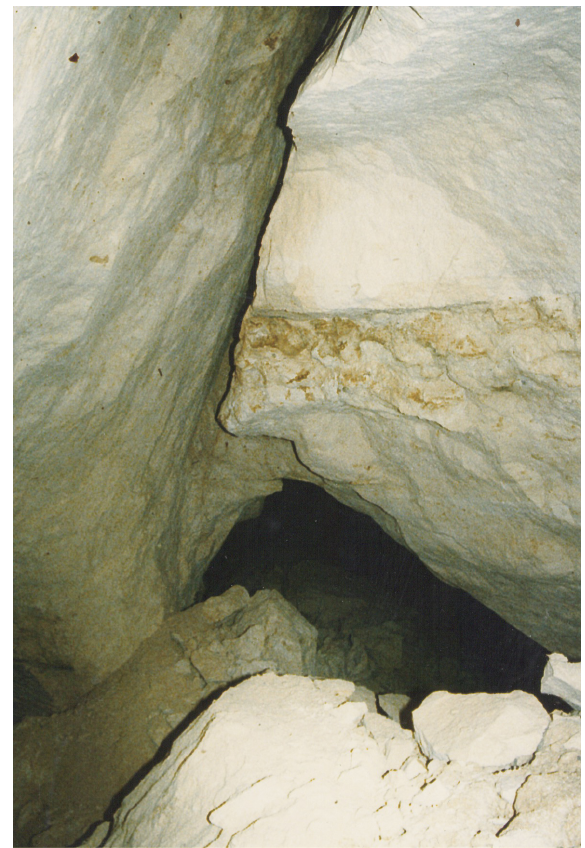
Figure 4. Collapse-induced fault in the rock overburden of the Hei-